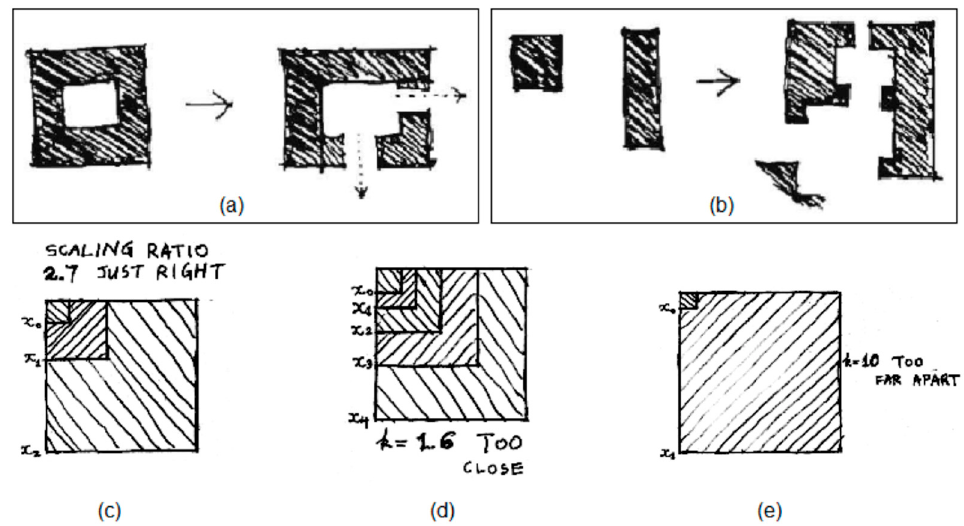
Figure 4. Good or bad as a matter of fact rather than an opinion. Note: A bad space—( a ) too close or ( b ) too open—is transformed into a good space, creating a sense of belonging [2]. The scaling ratio is between 2 and 3, as observed by Alexander [1], tends to lead to a good design or structure, while the scaling ratios of 1.6 ( d ) or 10 ( e ) are either too close or too far apart [5].